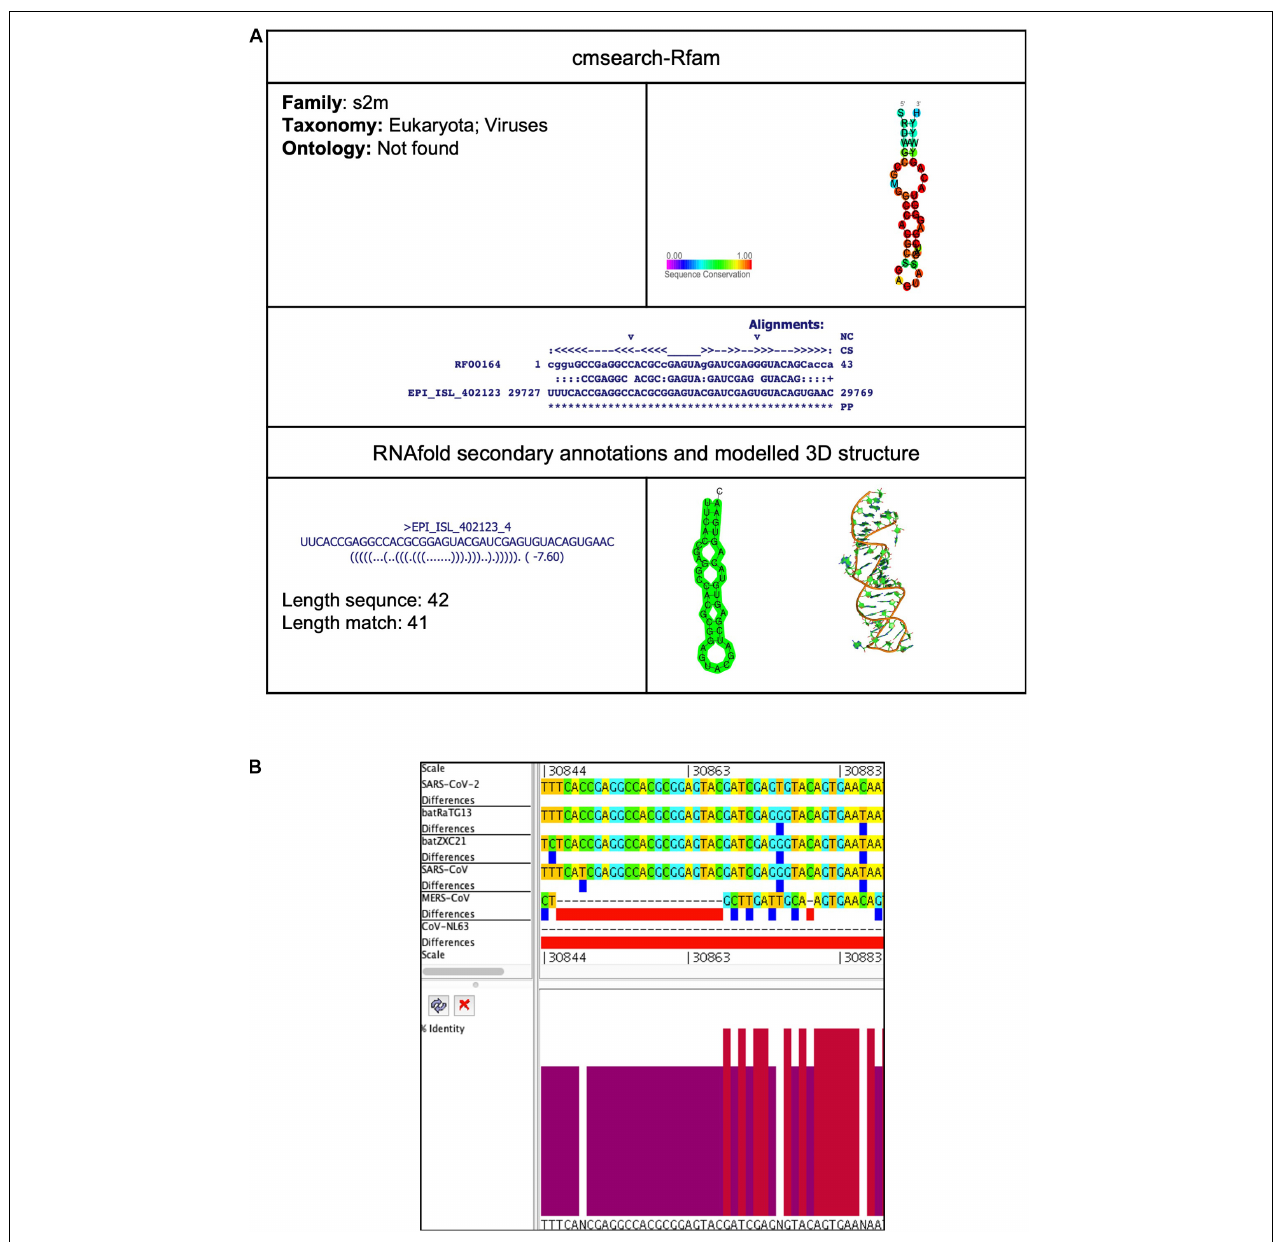
FIGURE 6 | s2m cis -acting RNA element in the SARS-CoV-2 genome. (A) The sequence and RNA structure of s2m is located in position 29,727–29,769 of the SARS-CoV-2 genome. In the 3-D structure, the phosphodiester backbone is shown in orange, and the nucleotides are shown in the sticks and filled rings with elemental coloring as C green, O red, and N blue. (B) Conservation of s2m RNA sequence from various CoVs. The s2m is located as aligned position 30,844–30,886. The navy blue box indicates mismatched nucleotides between the two sequences, and the red box indicates gaps between two sequences. Percentage identity in the histogram in which red indicates a perfect match and magenta indicates the low similarity of